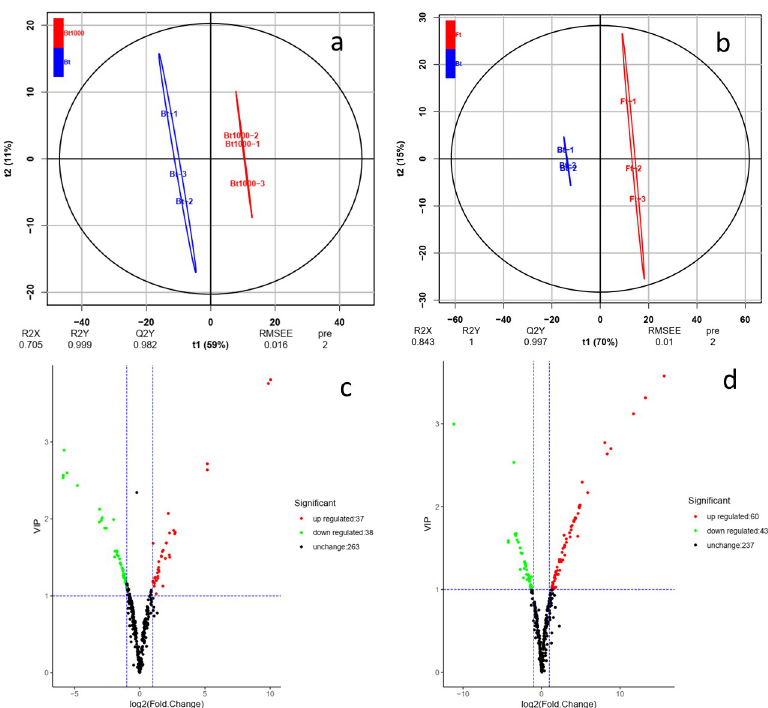
Fig 4. Differential metabolite analysis. (a): Orthogonal partial least squares discriminant analysis (OPLS-DA) score plot. Blue dots indicate Bt, and red dots indicate Bt1000. (b): OPLS-DA score plot. Blue dots indicate Bt, and red dots indicate Ft. (c): Volcano plot of differential metabolites between Bt and Bt1000. (d): Volcano plot of differential metabolites between Bt and Ft. Each point in the volcanic plot represents a metabolite, the abscissa represents the logarithm of the quantitative difference multiples of a metabolite in two samples, and the ordinate represents the variable importance in project (VIP) value. The green dots in the figure represent downregulated differentially expressed metabolites, the red dots represent upregulated differentially expressed metabolites, and the black dots represent detected metabolites but that are not significantly different. Ft indicates the flowering type, Bt indicates closed bud type and Bt1000 indicates MeJA-treated closed bud type